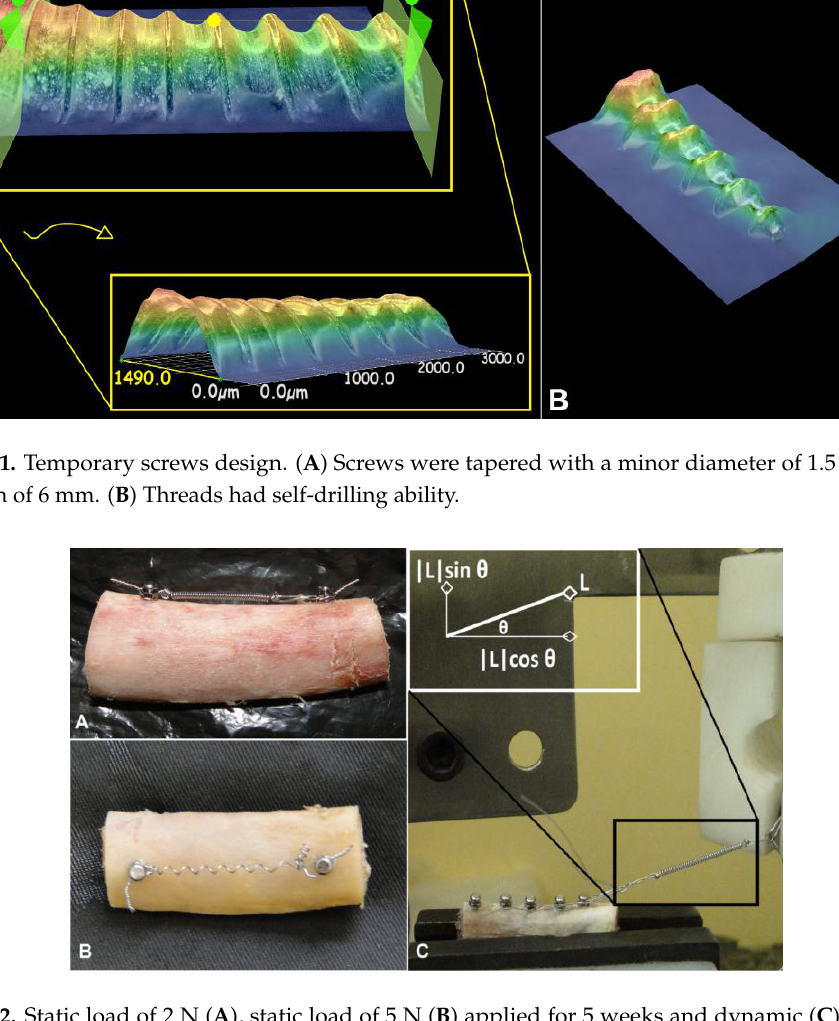
Figure 2. Static load of 2 N ( A ), static load of 5 N ( B ) applied for 5 weeks and dynamic ( C ) loads in temporary screws attached in pig rib bones. Vertical (pull out) and horizontal (pulling) components of the dynamic load ( L ), and the angle (θ) between L and a horizontal baseline, are shown. θ was 10° during closed mouth and 15° during opened mouth simulations. | L | was in range of 2–5 N and 5–7 N. Static load remained stable for 5 weeks at 2 N.